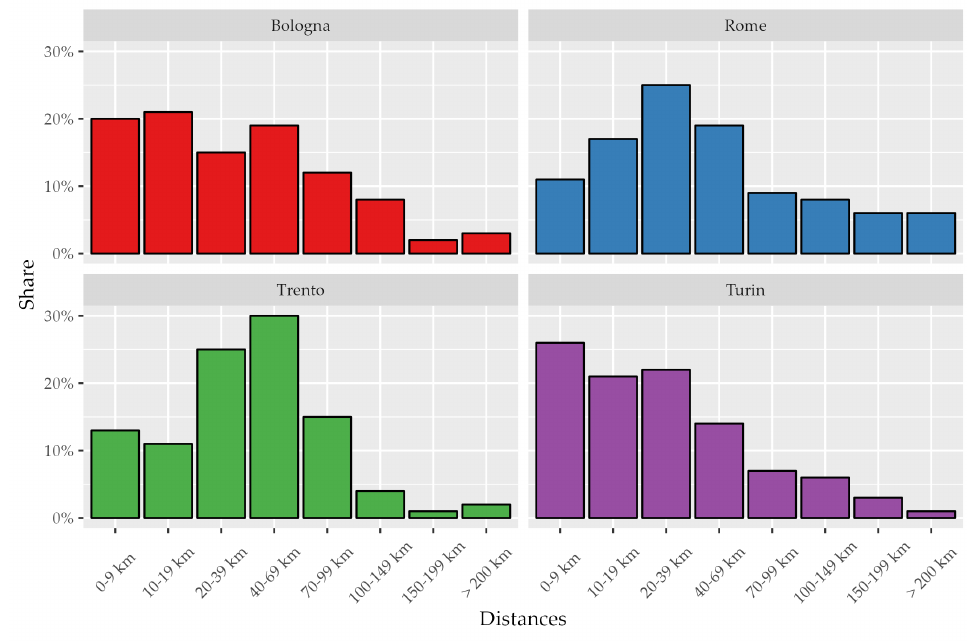
Figure 2. Daily commuting distance of workers from the survey in the four cities.